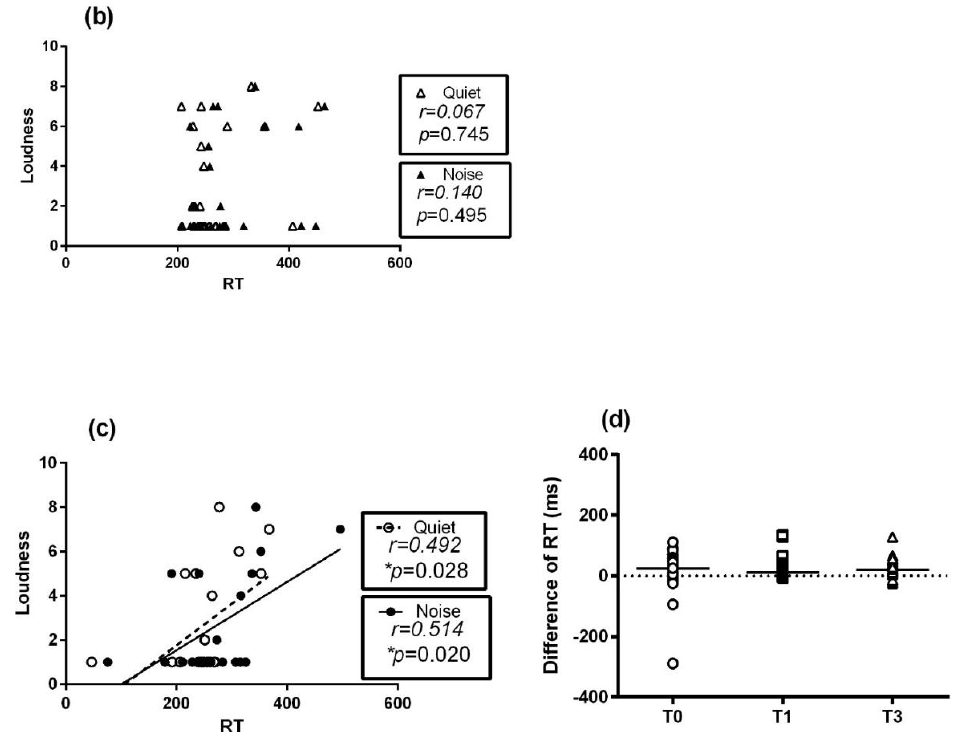
Figure A2. The correlation between tinnitus loudness and reaction time ( a ) before treatment, T0; ( b ) 1 month after treatment, T1; and ( c ) 3 months after treatment, T3. ( d ) Scatter plots of tinnitus loudness and the differences in reaction time between noise and quiet at T0, T1, and T3. RT: reaction time; r: Spearman correlation coefficient; * p < 0.05.